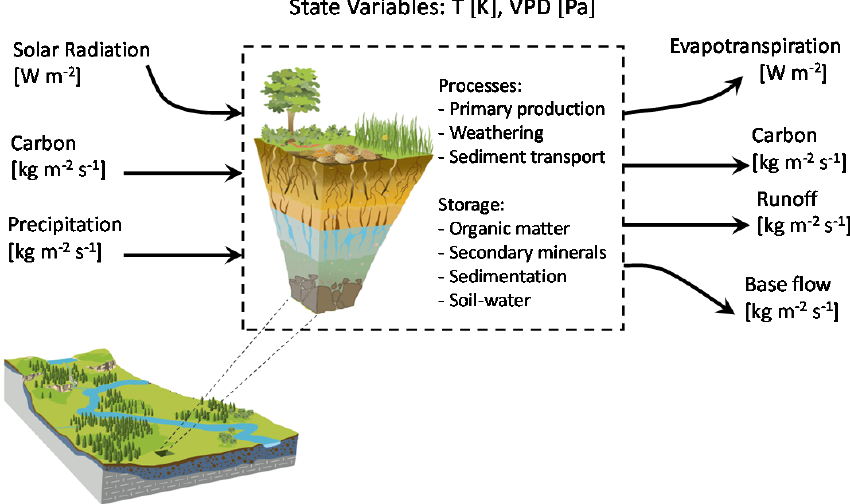
Figure 1. Conceptual diagram of the critical zone as an open thermodynamic system described by the state variables of temperature ( T ) and vapor pressure deficit (VPD), and energy and mass flux terms deriving from solar radiation, precipitation, and carbon input as primary production. The energy and mass transfer drives internal critical zone processes, change and storage of internal energy and mass, and export of dissipative products in the form of evapotranspiration, carbon from plant and microbial respiration and runoff and baseflow. Note that geophysical energy and mass transfers associated with tectonics and denudation are not included here. Modified from Rasmussen et al. (2011b)